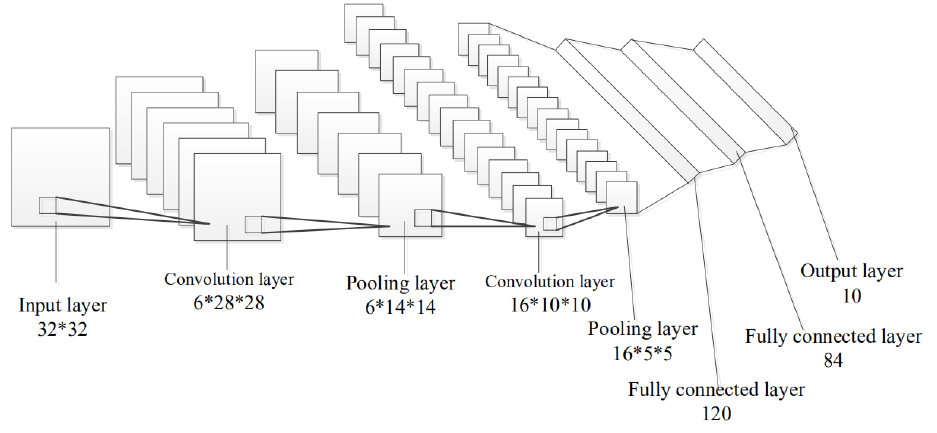
Figure 7. Structure diagram of a convolutional neural